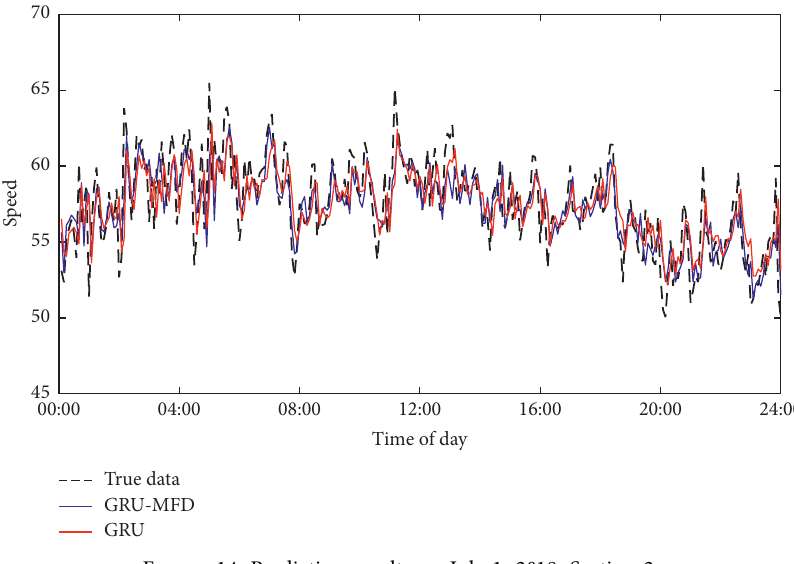
Figure 14: Prediction results on July 1, 2018, Section 2.